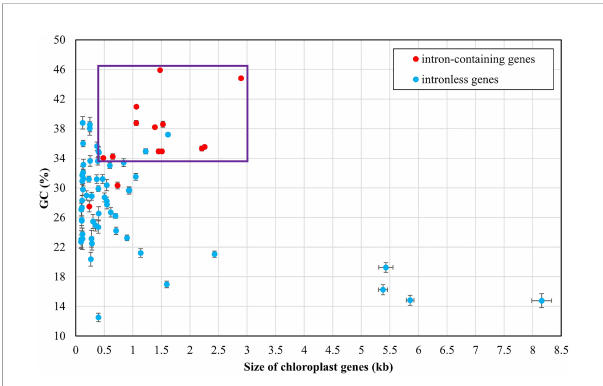
FIGURE 4 Comparison of GC composition and gene size among 71 PCGs and three rRNAs of Ulva plastomes. Error bars represent the standard deviation (SD). Purple box represents the distribution area of most intron-containing